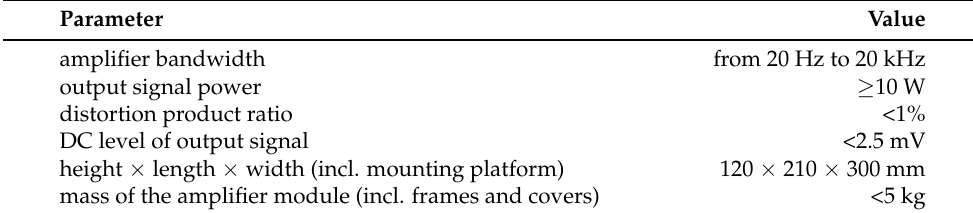
Table 1. Assumed parameter values for the LF amplifier under design. Parameter Value amplifier bandwidth from 20 Hz to 20 kHz output signal power ≥ 10 W distortion product ratio <1% DC level of output signal <2.5 mV height × length × width (incl. mounting platform) 120 × 210 × 300 mm mass of the amplifier module (incl. frames and covers) <5